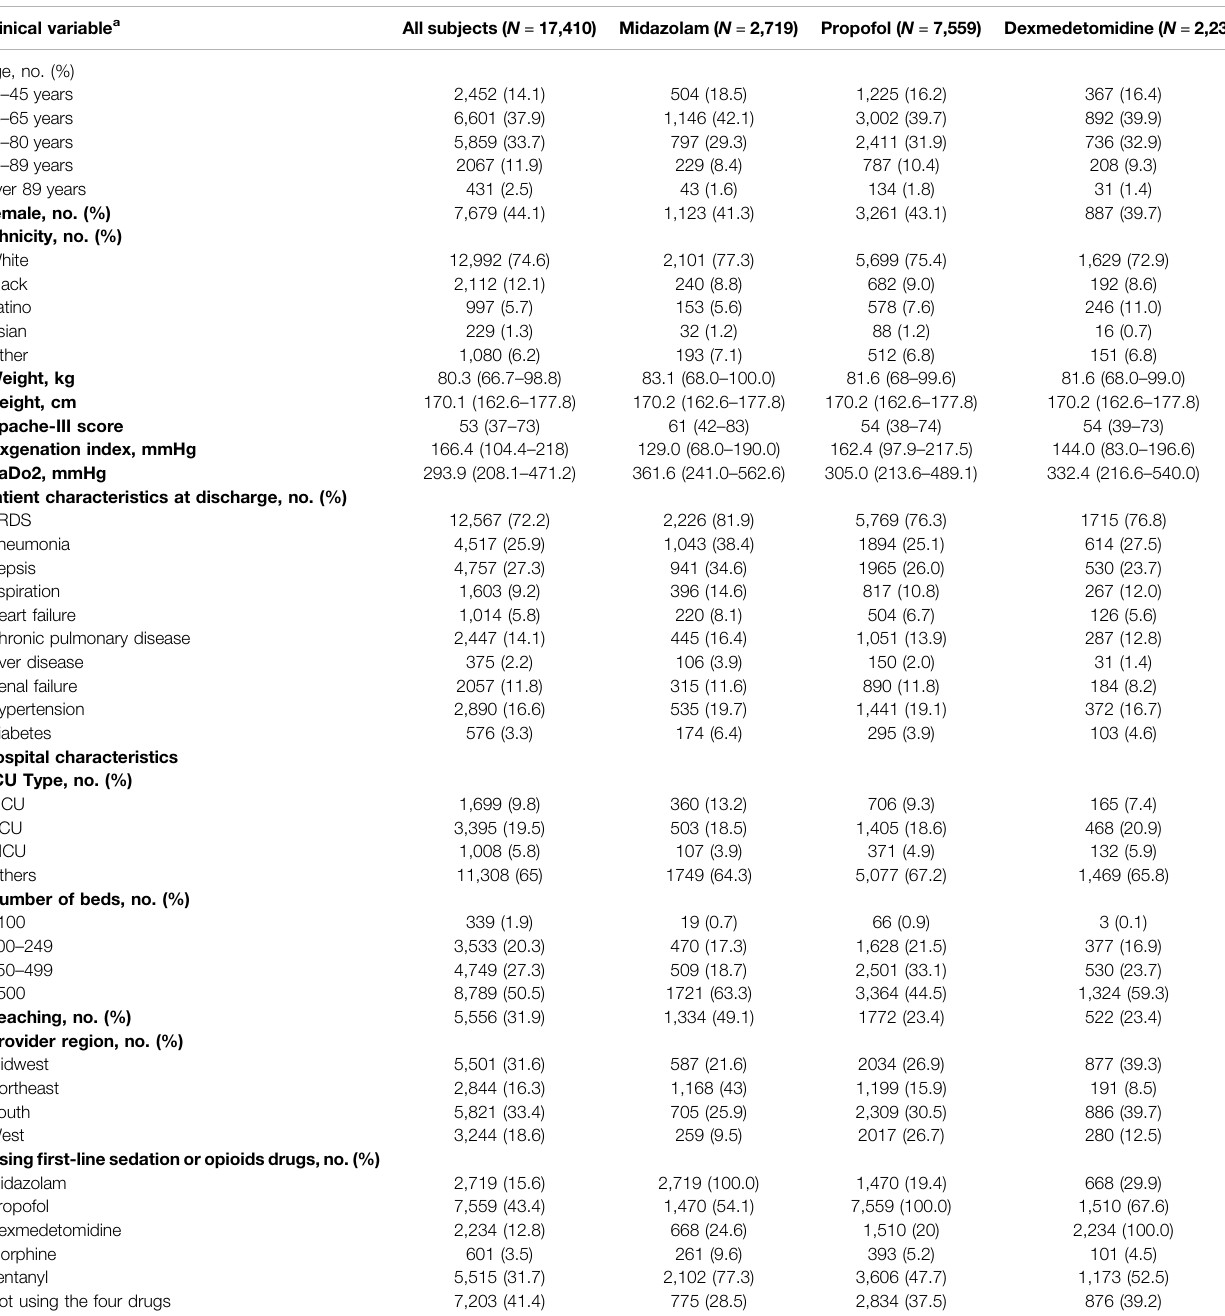
TABLE 1 | Baseline characteristics of the patients. Clinical variable